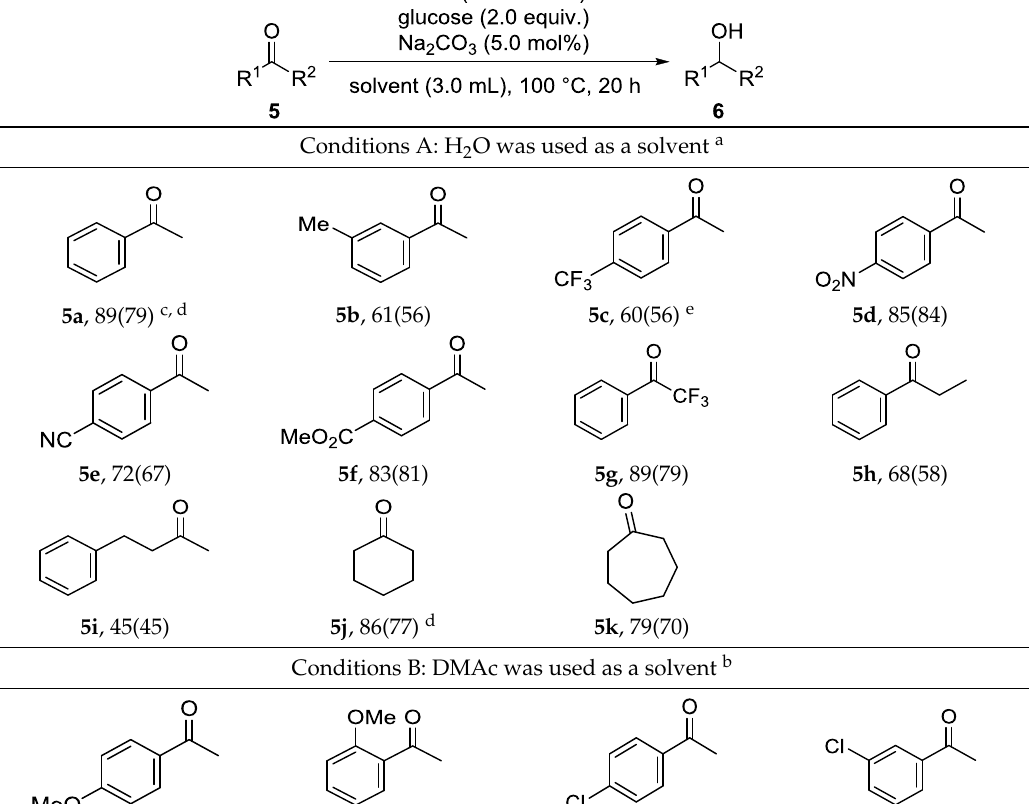
Table 2. Transfer hydrogenation of various ketones catalyzed by 1 using glucose as a hydrogen donor.